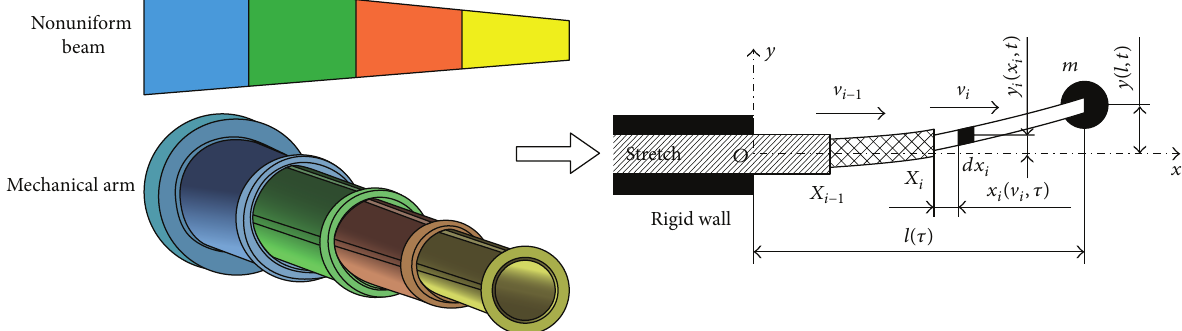
Figure 1: Axially moving stepped beam with different length and tip